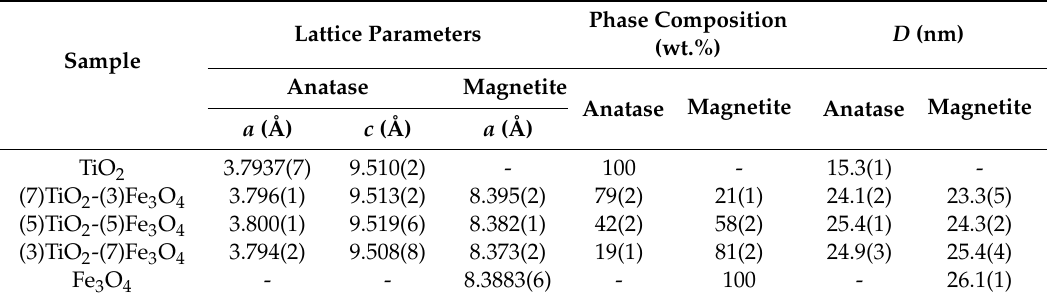
Table 2. Lattice parameters, phase composition, and average crystalline size for TiO 2 -Fe 3 O 4 composite materials.